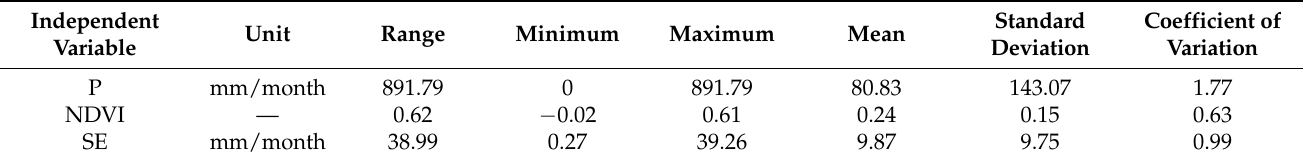
Table 2. Descriptive statistics of the P, NDVI and SE, from January 2012 to March 2022.